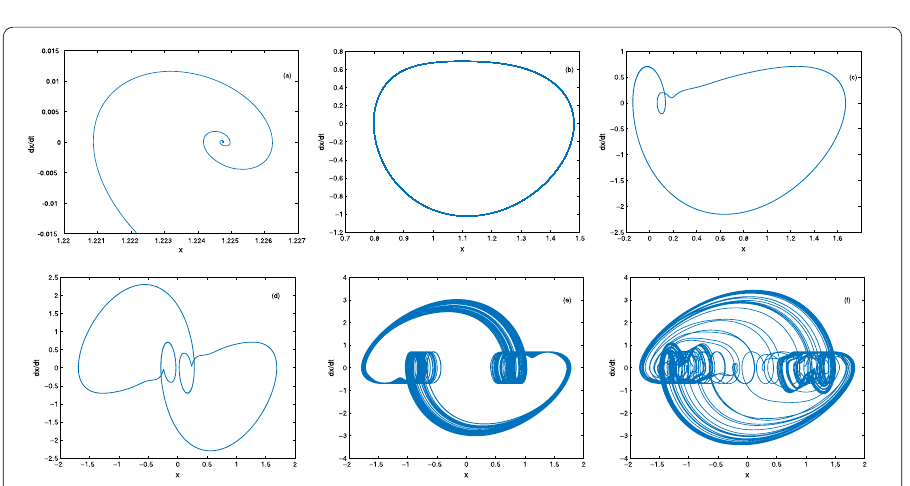
Figure 7 The phase plane plot in x – dx / dt space for different τ : ( a ) τ = 0.3 (stability), ( b ) τ = 0.6 (period-1), ( c ) τ = 0.87 (period-2), ( d ) τ = 0.9 (period-4), ( e ) τ = 1.03 (chaos), ( f ) τ = 1.1 (chaos) with parameter γ = 1.5